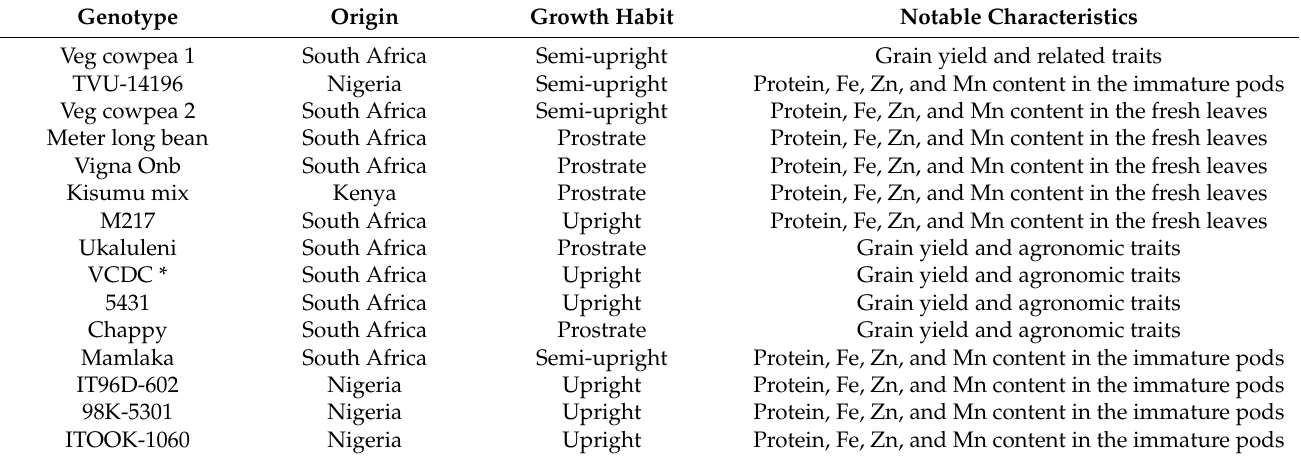
Table 1. Description of cowpea